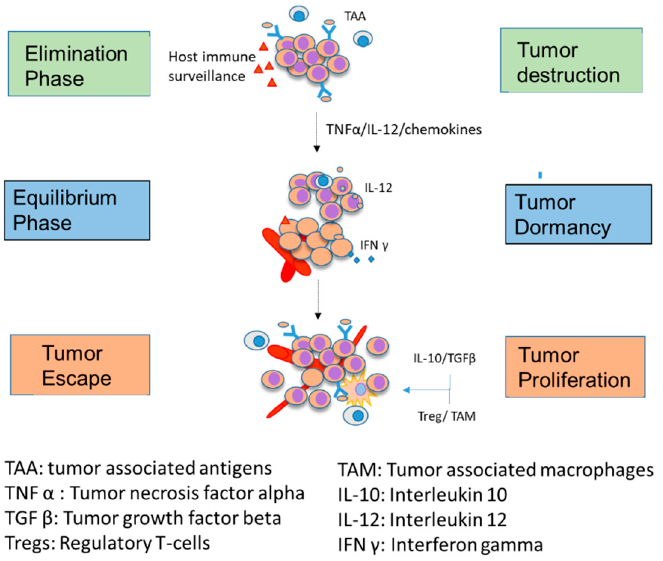
Figure 1. Cancer Immune editing: Cancer cells develop and proliferate through a process of immune editing, a process based on three Es (E 3 ), namely, elimination, equilibrium, and escape. The elimination phase is marked by the effective control of host immune surveillance and tumor removal. However, with a breach in immunosurveillance or ineffective host response, the tumor can undergo a dormant phase. Tumor dormancy is reversible and can become active in the presence of pro-tumor factors, leading to tumor proliferation and growth.